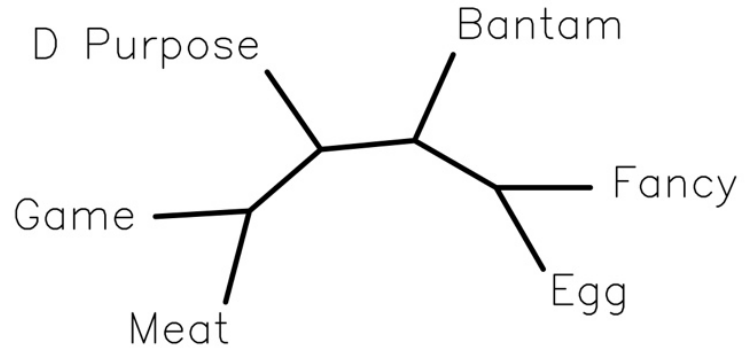
1 Genetic differentiation values as calculated in EIGENSOFT. Above the diagonal: D (average divergence) values between population groups; on the diagonal: D (average divergence) values within population groups (in parentheses); below the diagonal: pairwise F ST values between population groups ± standard deviations (in italics). All the pair-wise differences as assessed by F ST were significant (shown by analysis of variance, p < 0.05). An unrooted neighbor-joining dendrogram built on the basis of pairwise F ST values for six PCM groups (Figure 3) seemed to adequately reflect both TCM and PCM, and the contemporary concept of the main evolutionary branches of domestic chickens [3]. Here- with, FBs and BTBs were closer to ETBs (on the right side of the tree), GBs to MTBs (on the left side of the tree), and DPBs occupied an intermediate position between these two major parts of the dendrogram.